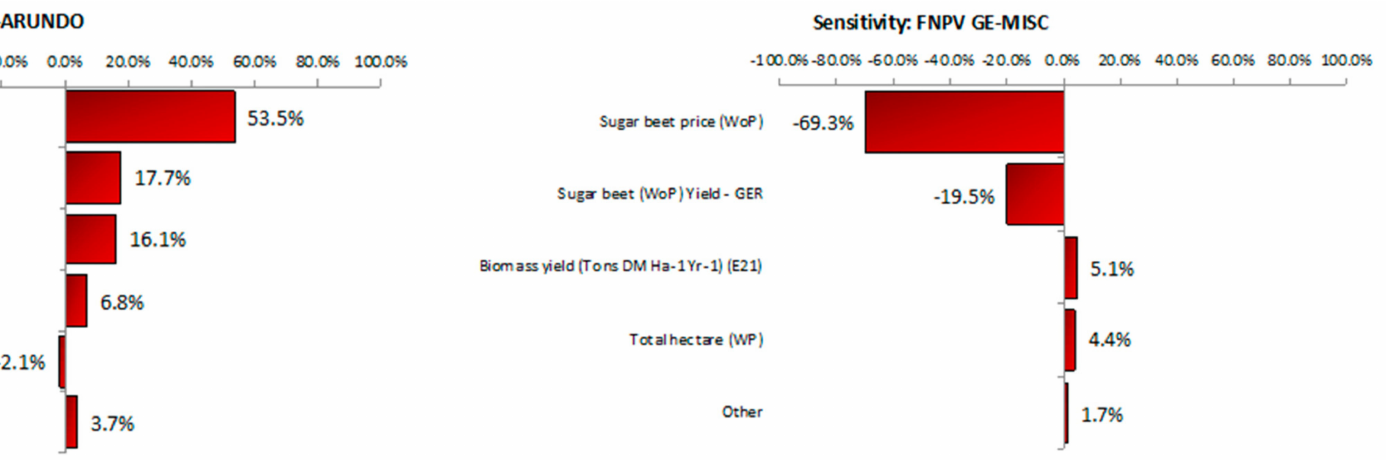
Figure A2. Tornado plot sensitivity analysis of selected